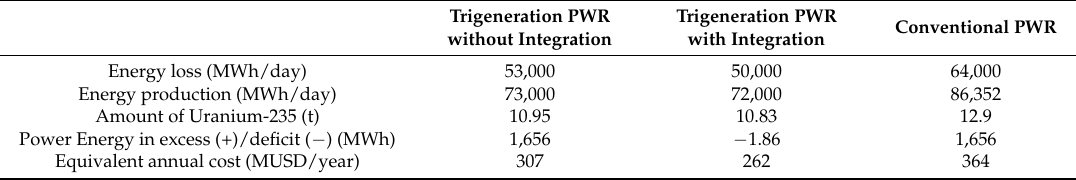
Table 10. Comparison between conventional PWR, PWR as a trigeneration system with and without integration.